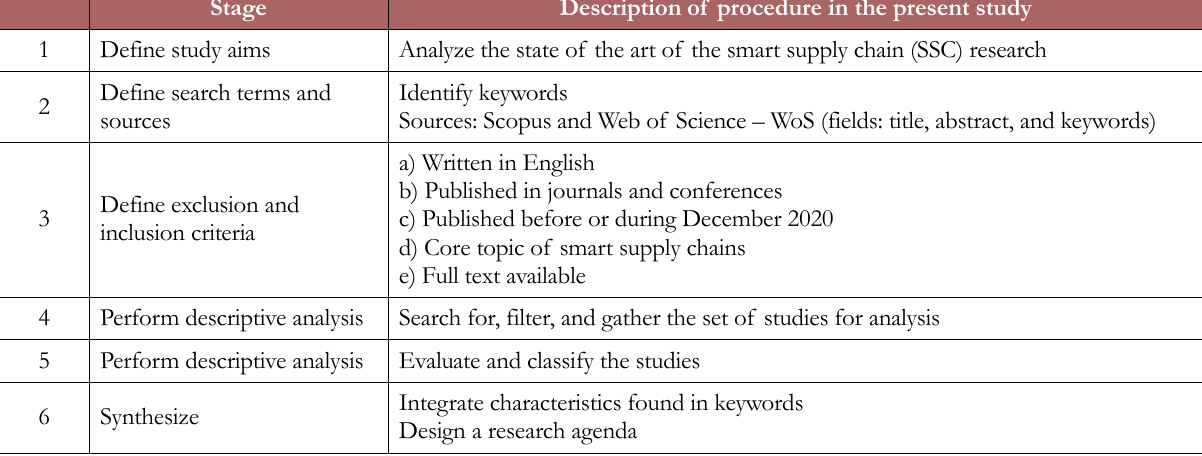
Table 1. Stages of the systematic literature